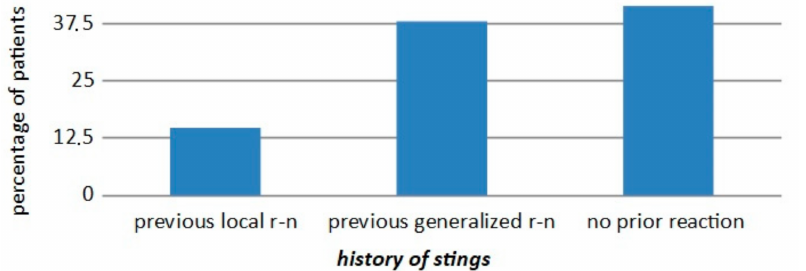
Figure 8. The proportion of patients with insect sting anaphylaxis versus those with a history of stings with previous local reaction (r-n) or previous generalized reaction, or no prior reaction (tolerance).